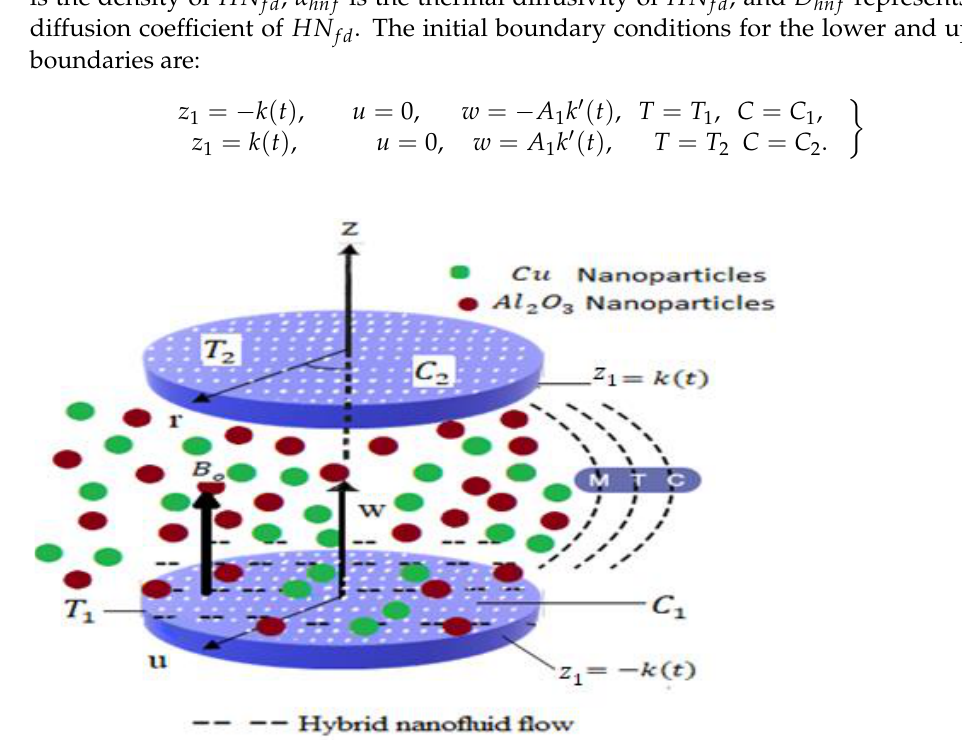
Figure 1. Physical Figure 1. Physical model.